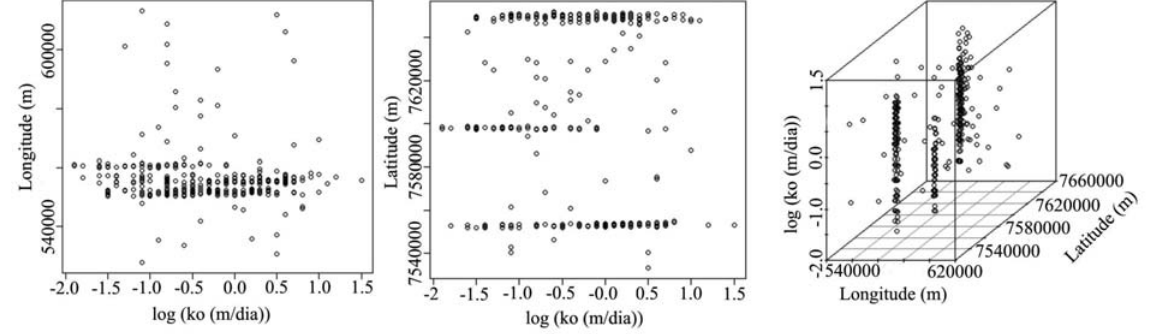
Figura 5. Gráficos de tendência dos dados transformados de condutividade hidráulica